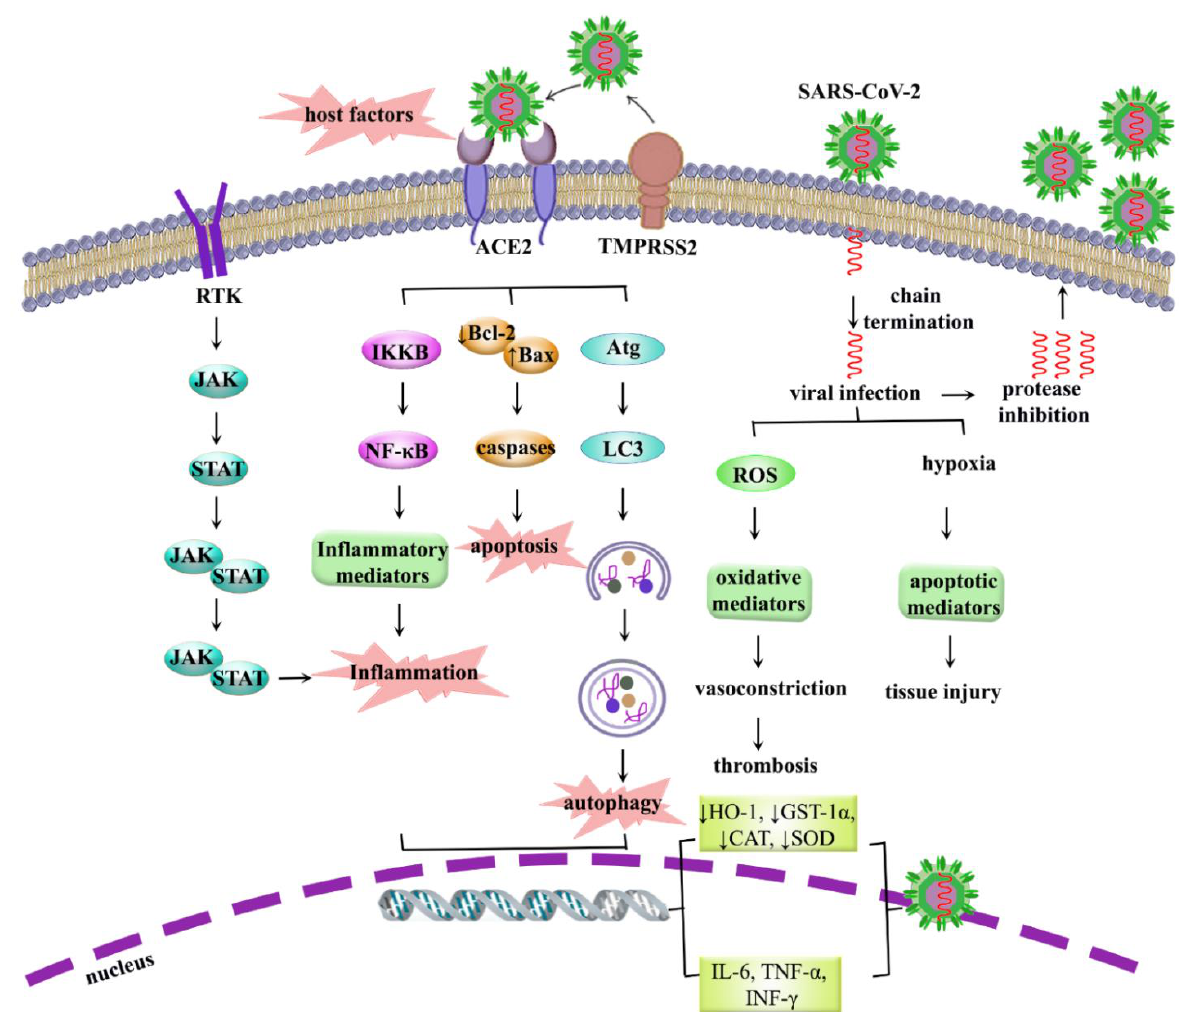
Figure 1. Multiple dysregulated pathways in COVID-19. ACE2: angiotensin-converting enzyme 2; Atg: autophagy related; Bcl-2: B-cell lymphoma 2; CAT: catalase; COX: cyclooxygenase; GST: glutathione S-transferases; HO: heme oxygenase; IFN: interferon; IKKβ: IκB kinase β; IL: interleukin; JAK: Janus kinase; LC3: light chain 3; NF-κB: nuclear factor kappa B; RdRP: RNA-dependent RNA polymerase; RTK: receptor tyrosine kinase; STAT: signal transducer and activator of transcription; TMPRSS2: transmembrane protease serine 2; TNF-α: tumor necrosis factor-α.